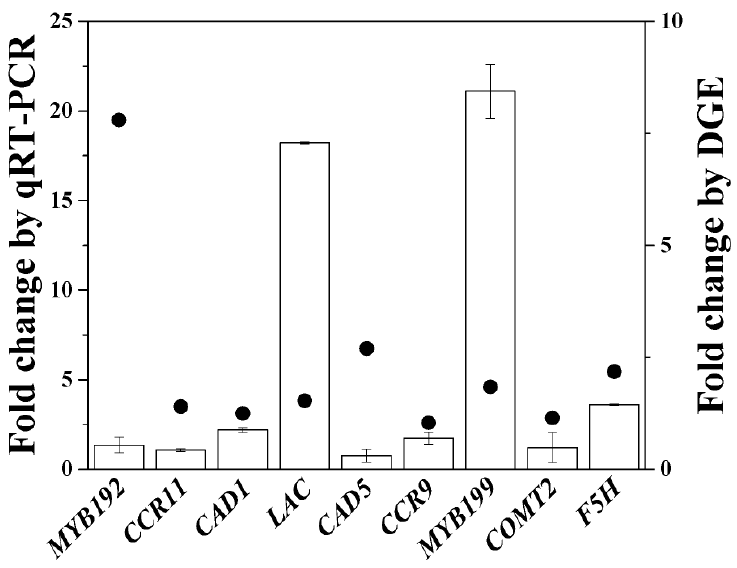
Figure 5. qRT-PCR confirmation of differentially expressed genes from digital gene expression analysis. ● Solid circles and histograms represent the results obtained from RNA-Seq and qRT-PCR, respectively. Bars indicate the mean ± SE ( n = 3). Detailed information on the selected genes is available in Table S1.